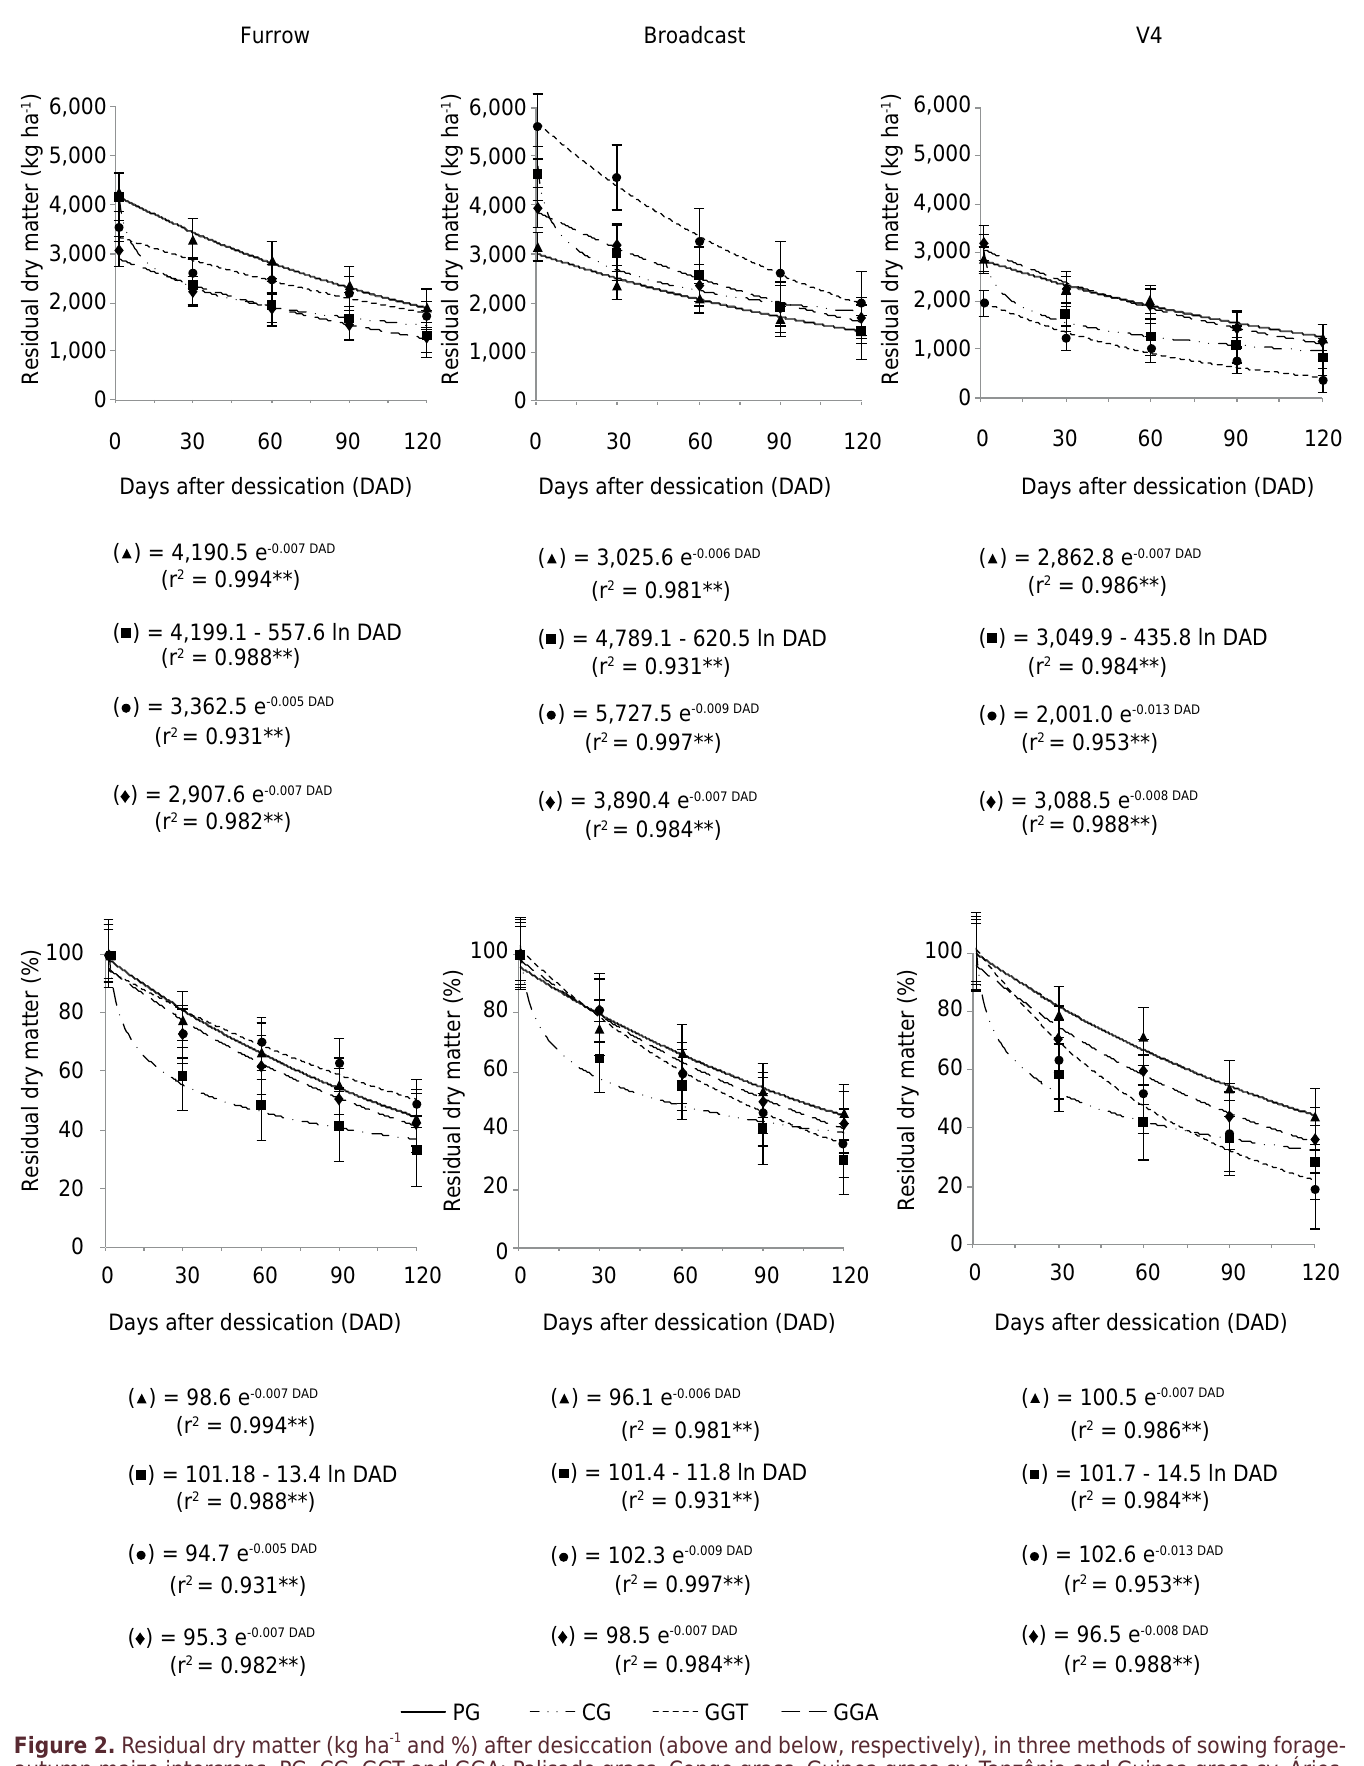
Figure 2. Residual dry matter (kg ha -1 and %) after desiccation (above and below, respectively), in three methods of sowing forage- autumn maize intercrops. PG, CG, GGT and GGA: Palisade grass, Congo grass, Guinea grass cv. Tanzânia and Guinea grass cv. Áries, respectively. **: significant at 1 %